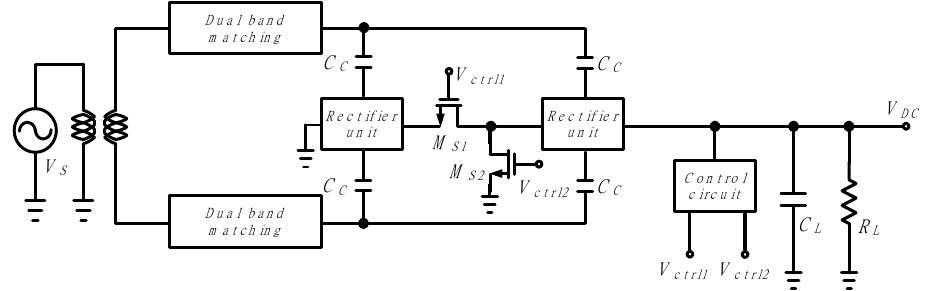
Figure 3. Block diagram of the proposed dual-band adaptive RF–DC converter.